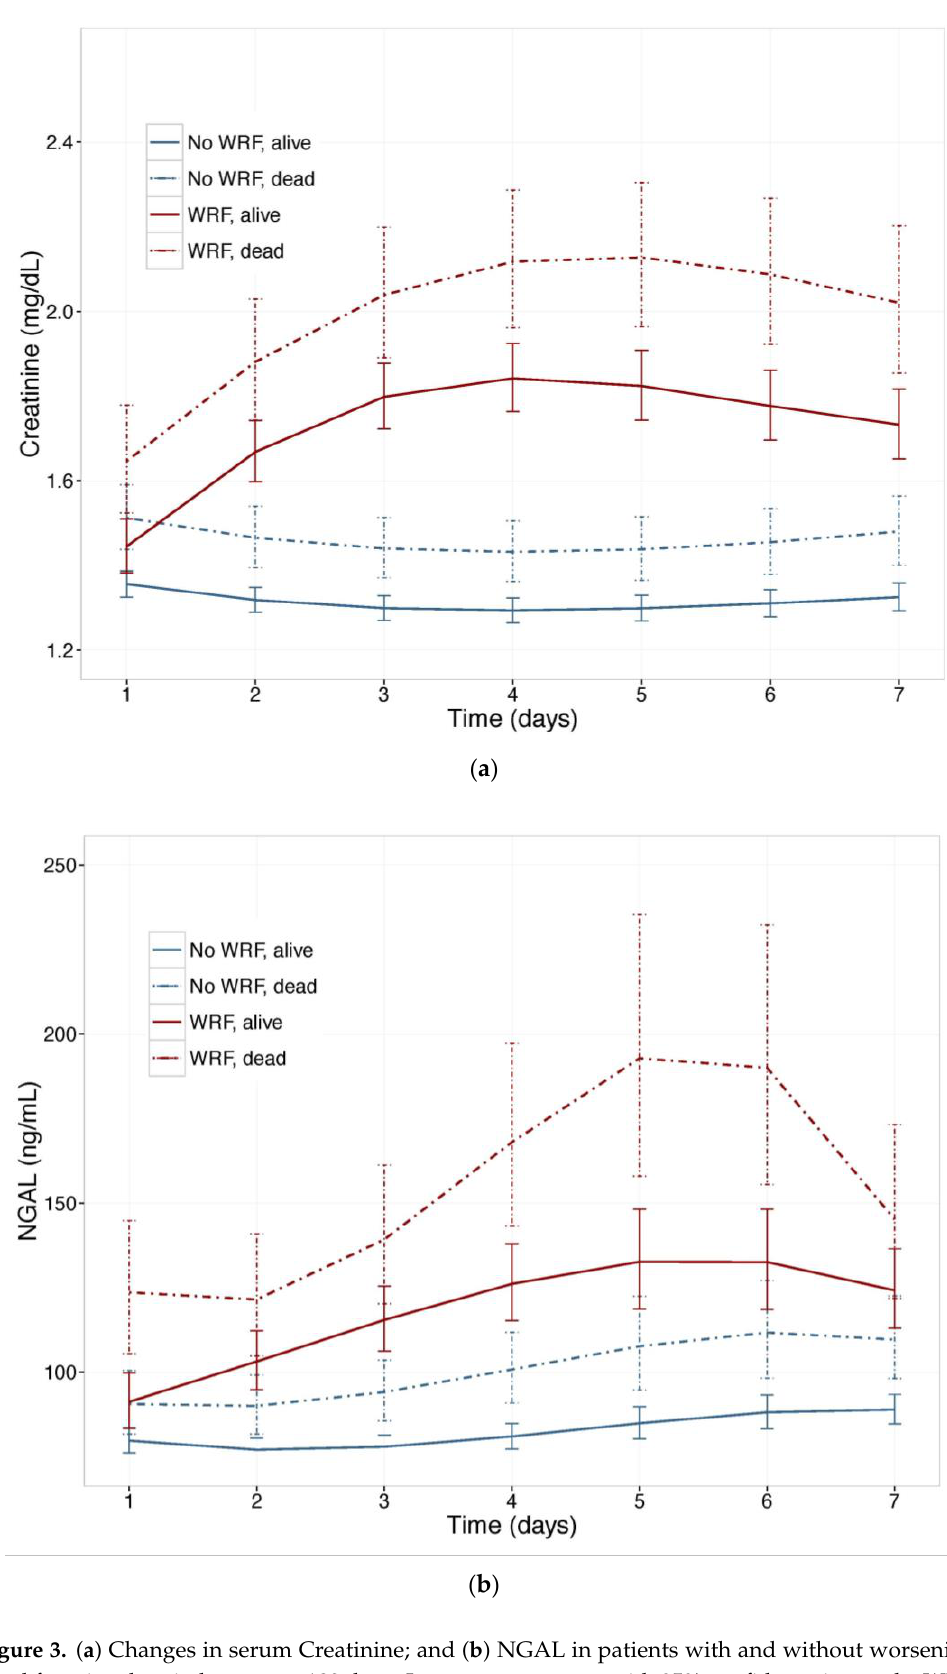
Figure 3. ( a ) Changes in serum Creatinine; and ( b ) NGAL in patients with and without worsening renal function, by vital status, at 180 days. Least square means with 95% confidence intervals. WRF: worsening renal function, defined as a creatinine increase of ≥0.3 mg/dL by day 4.